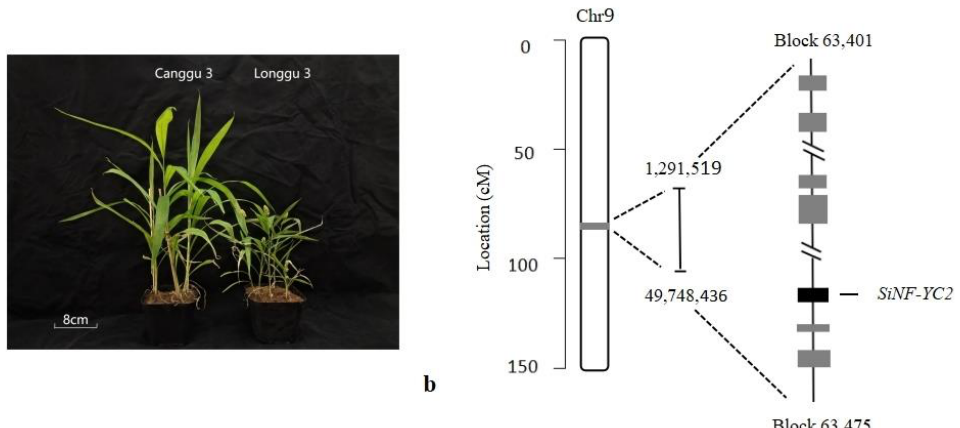
Figure 1. QTL mapping and candidate gene screening for early-maturity traits in foxtail millet. ( a ) Heading phenotype of parent plants. ( b ) Location of SiNF-YC2 on the chromosome.